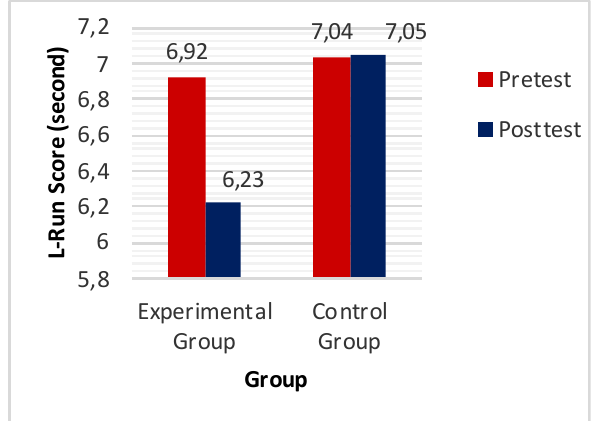
Figure 3. The Comparison Scores of Pretest and Posttest for L-Run test between and within experimental group and control group after Six Weeks of CoBAgi Training Table 4. The Comparison of Pretest and Posttest Between and Within Control Group and Experimental Group in Carioca Score after Six Weeks with CoBAgi Training Group